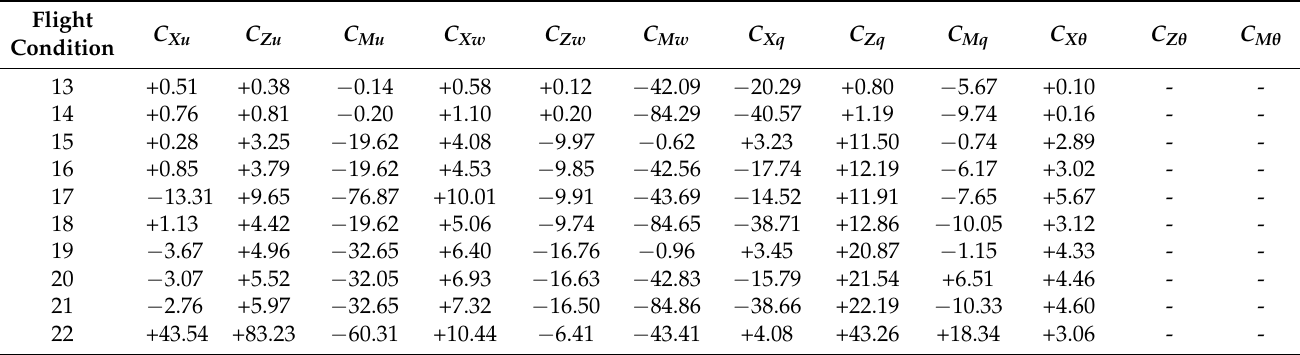
Table 31. Relative accuracy of takeoff longitudinal stability derivatives (percentage discrepancy % between extrapolation and